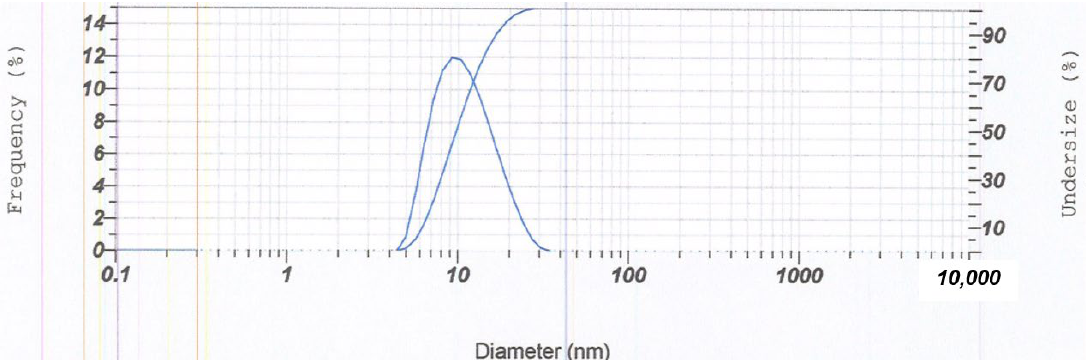
Figure 4. Droplet-size distribution graph for the optimized formula.